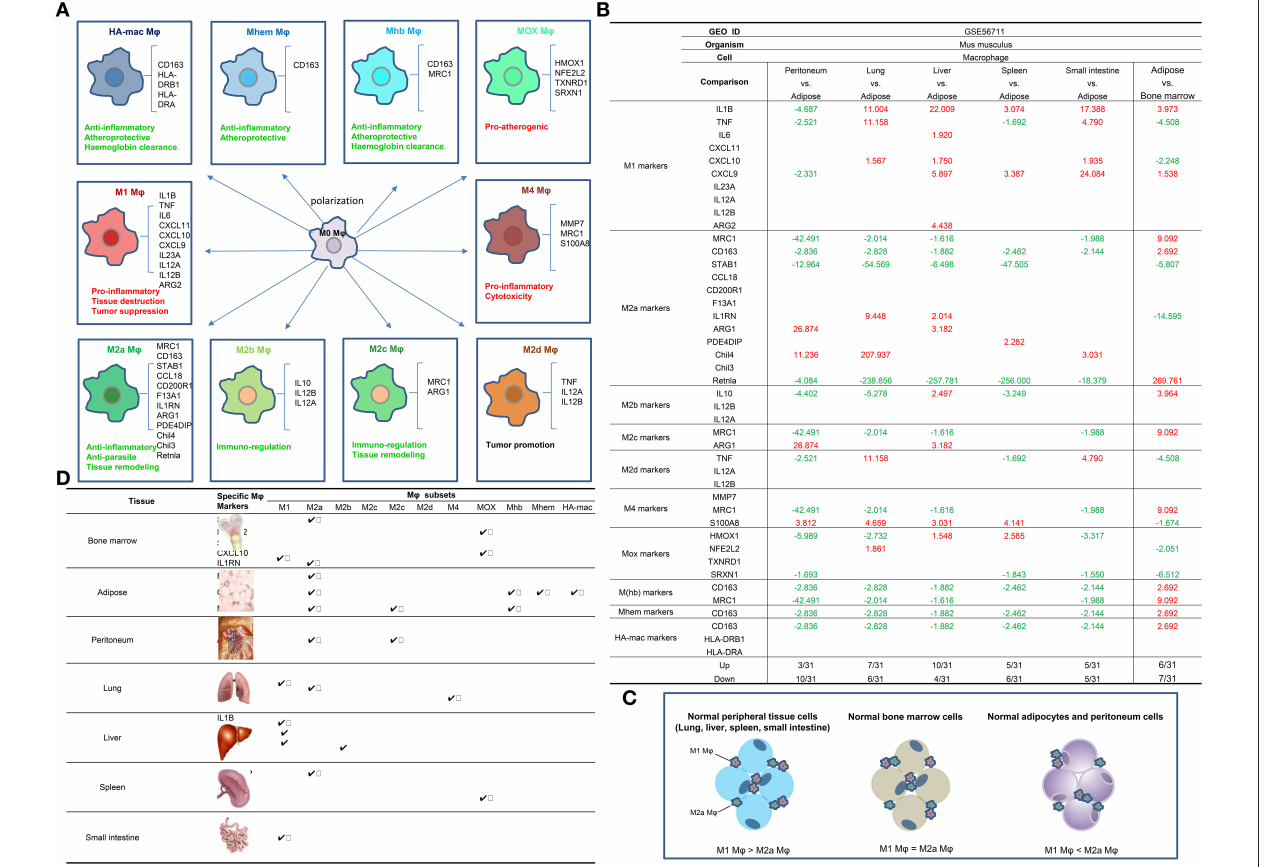
cell death protein 1, CD279) binding-mediated forward signaling (53,